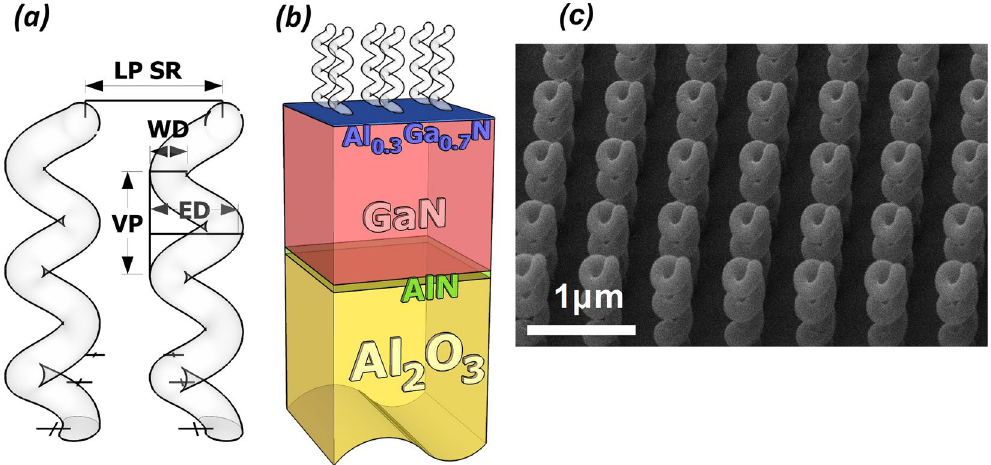
Figure 1. ( a ) Schematic view of the single helix, with another neighbor element. The wire diameter (WD) is 110 nm, the external diameter (ED) is 300 nm, and the vertical pitch (VP) is 300 nm. The helix is supposed to have a perfectly round shaped cross section. The lattice period (LP) of the square array is 700 nm. ( b ) Schematic view of the substrate laying beneath the helices layer. It consists of a GaN/AlGaN heterostructure where a two dimensional electron gas allows for charge effect management during the helices growth by FIBID 10, 24 . All